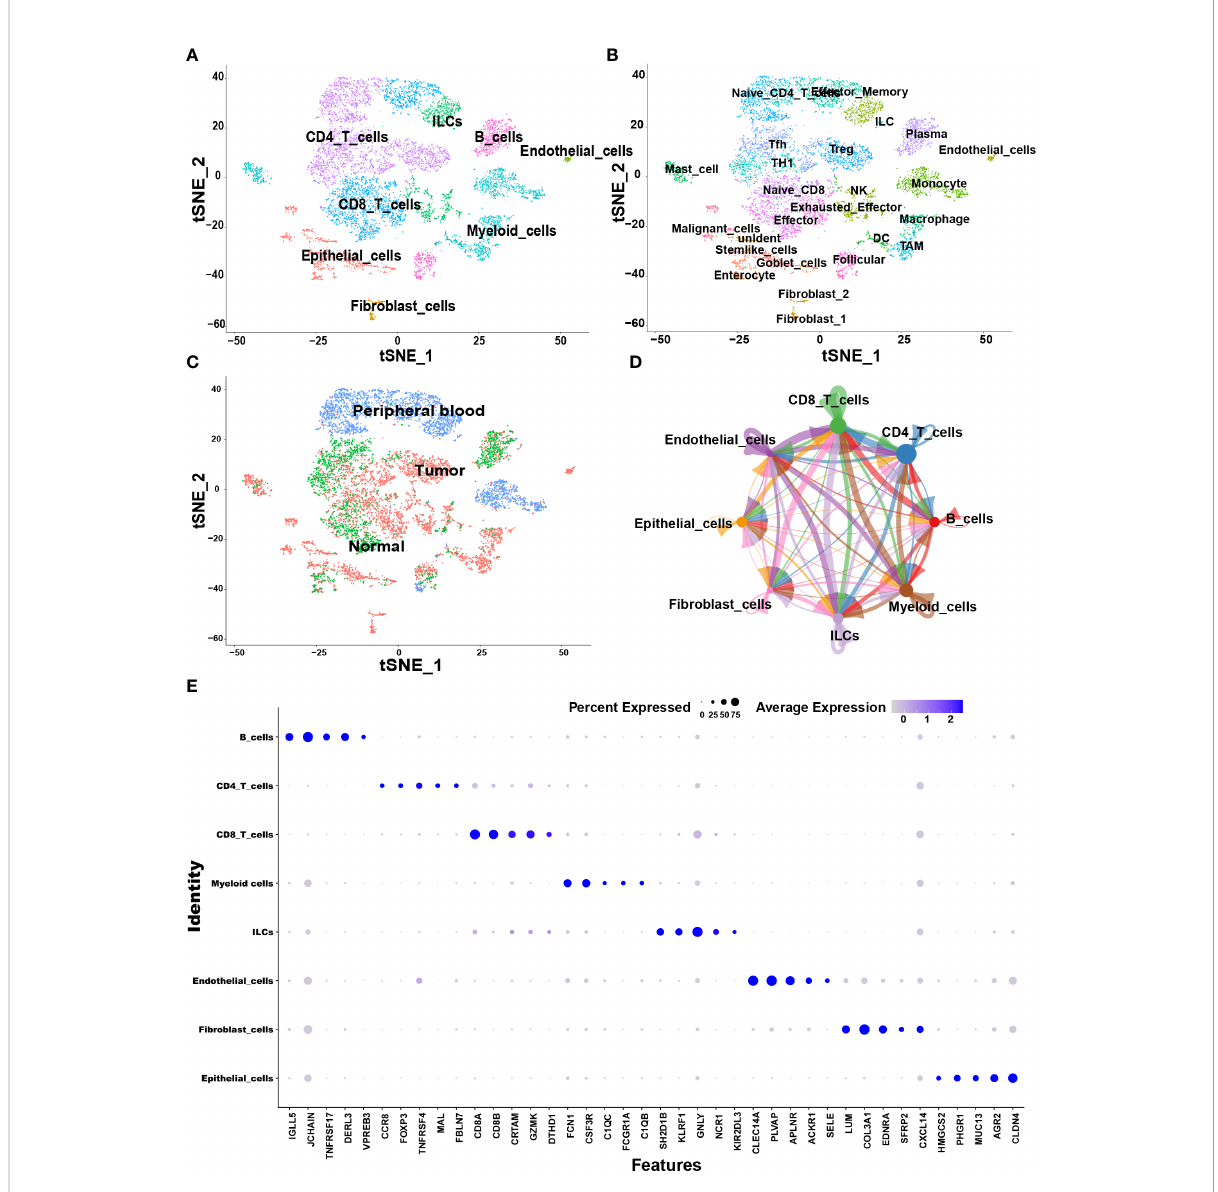
FIGURE 1 Overview of single cells derived from tumors, adjacent tumor tissues, and peripheral blood of CRC patients. (A – C) tSNE plots of all the single cells color-coded for (A) eight major cell types, (B) 25 sub-cell types, (C) tissue origins (tumor, adjacent to tumor or blood). (D) Interaction network among major cell types constructed by CellChat; circle sizes represent interaction weights; the thicker line indicates more weight and strength of the interactions between variable major cell types. (E) Bubble heatmap showing top fi ve marker genes of eight major cell types. Dot size indicates fraction of expressing cells, colored according to expression